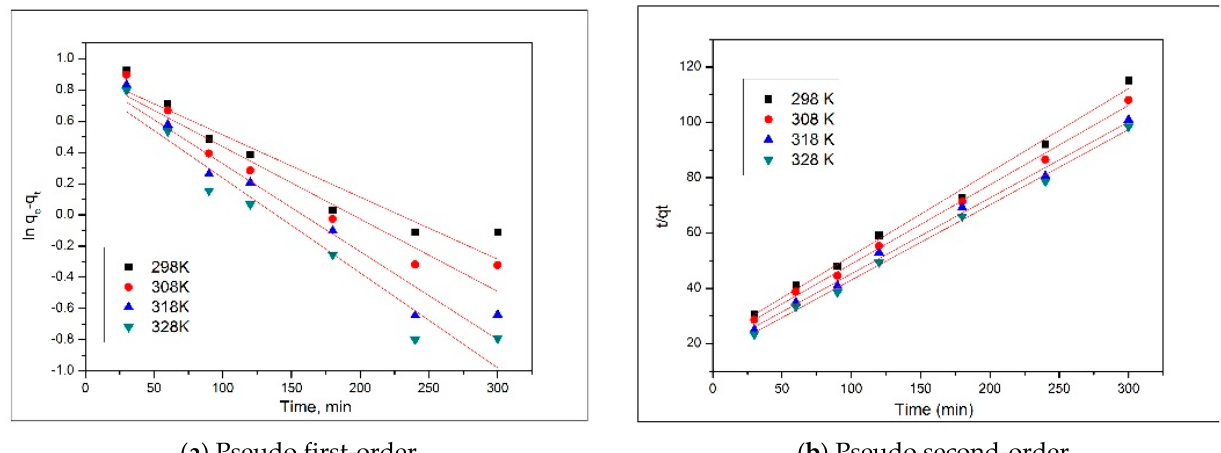
Figure 7. Kinetic models for Pd(II) adsorption onto XAD7-DB18C6, at different temperatures. Table 1. Kinetic parameters for adsorption of Pd(II) onto XAD7-DB18C6 material.